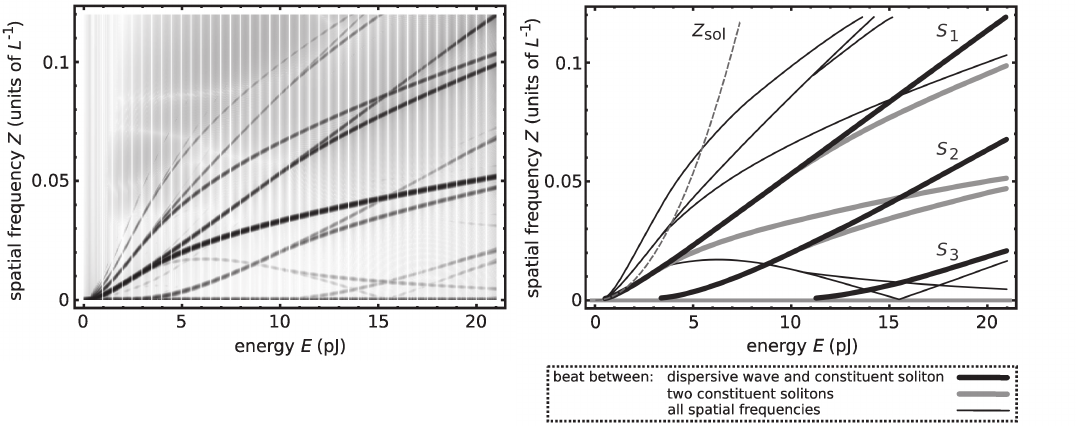
Figure 13. (Left) SRBA chart for an energy scan of a DM soliton. For an explanation of the procedure, and the apparent white vertical stripes in particular, see the text. (Right) Extract of the left panel, with standardized line types. The fundamentals pertaining to three constituent solitons are labeled S 1 – S 3 . The dashed line labeled ‘sol’ is for reference; it represents the spatial frequency for a non-DM soliton in a fiber with β 2 = β (from 2